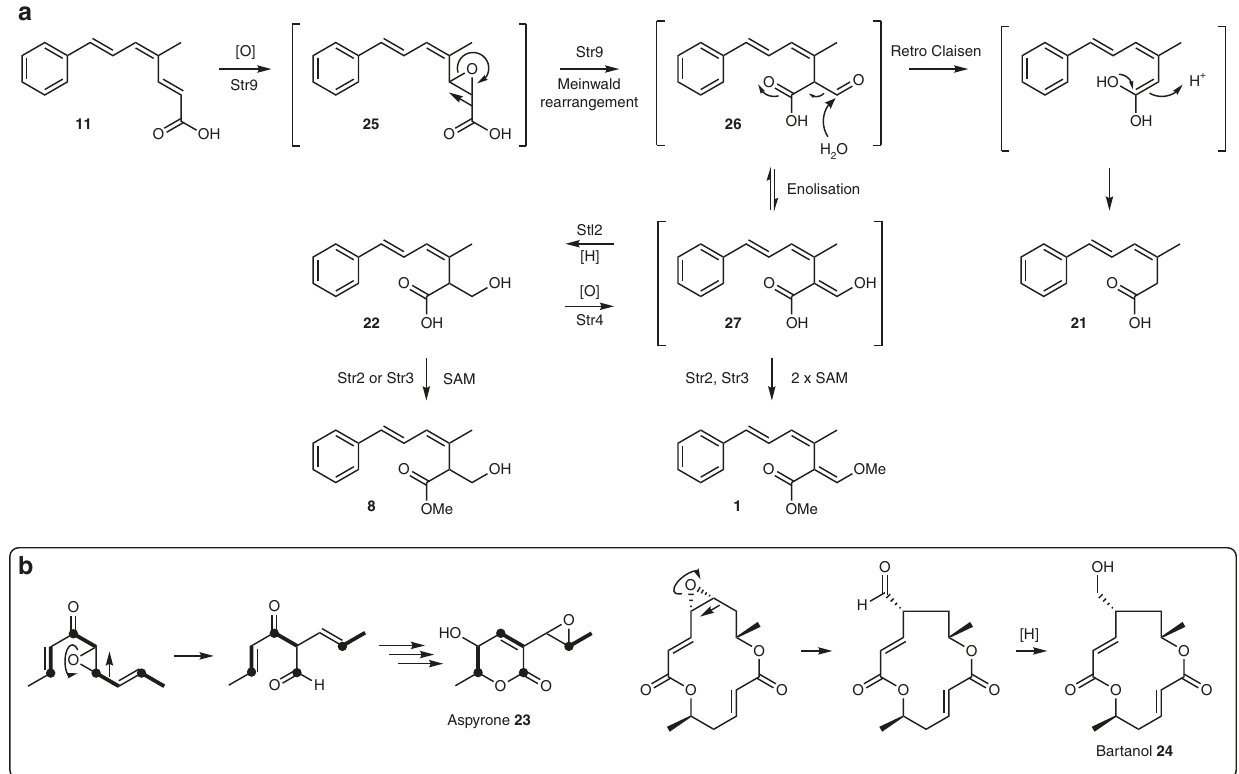
Fig. 7 Oxidative rearrangement of 11 on the pathway to 1 and shunts leading to observed compounds 21 and 22 . a Deduced pathway from prestrobilurin 11 to strobilurin A 1 . b Similar oxidative rearrangements observed during the biosynthesis of aspyrone 23 and bartanol